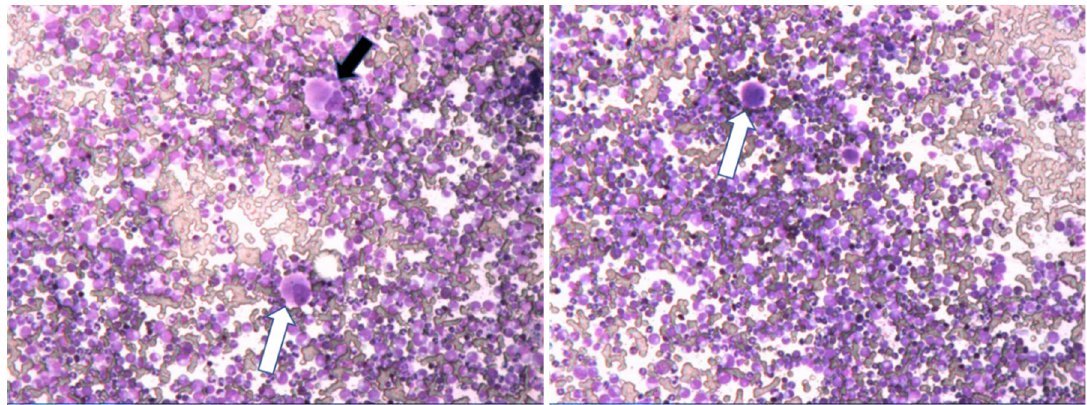
Figure 6. Significant hypercellular marrow at diagnosis of CML-CP showing also small hypolobulated megakaryocytes (black arrow) and micromegakaryocytes (white arrows). Magnification 80×.